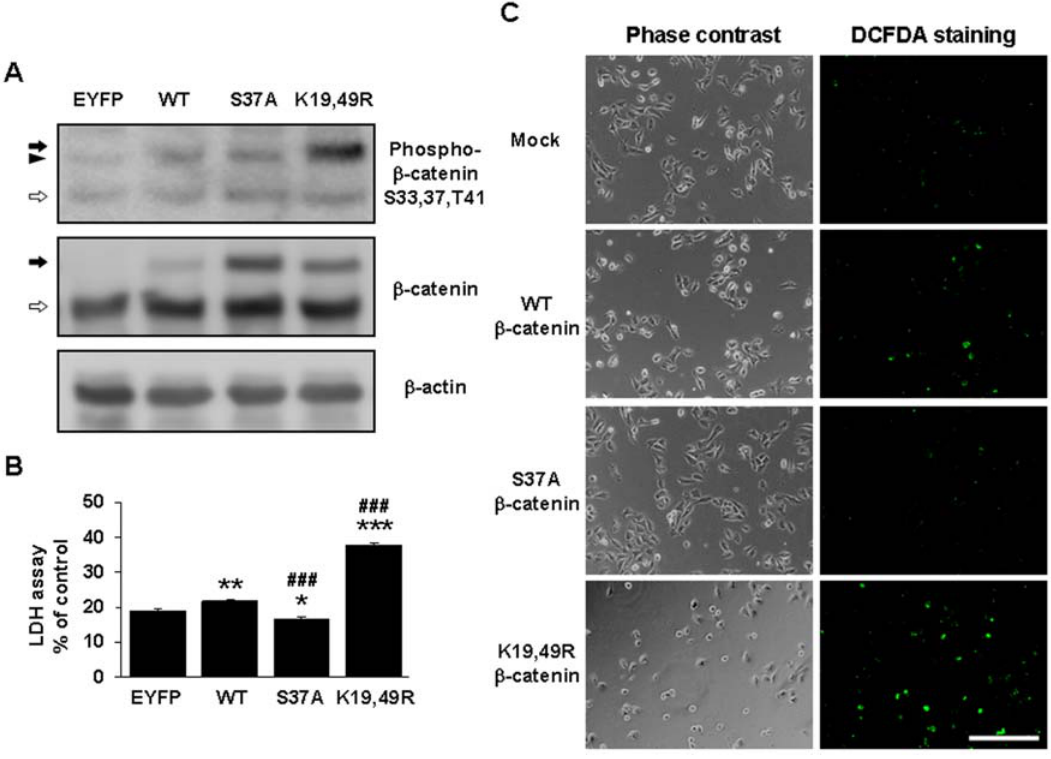
Figure 4. Accumulation of phospho- b -catenin induces cytotoxicity in H4 neuroglioma cells. (A) H4 cells were transiently transfected with EYFP vector, WT, and mutant b -catenin constructs in DMEM for 16 hr. K19/49R b -catenin-transfected cells showed higher immunoreactivity against anti-phospho- b -catenin (S33, 37, T41) without affecting endogenous b -catenin and b -actin levels. Filled and blank arrows indicate exogenous b - catenin-EYFP fusion protein and endogenous b -catenin, respectively. Arrowhead indicates nonspecific bands. (B) LDH release assay showed that K19/ 49R b -catenin induced cytotoxicity in the transfectants. The graph represents (%) of positive control. Data are means 6 SEM values of three independent experiments. * represents significant differences from EYFP vector-transfected H4 cells. *P , 0.05, **P , 0.01, ***P , 0.001. # represents significant differences from WT b -catenin-EYFP-transfected H4 cells. ### P , 0.001. (C) DCFDA staining showing ROS generation of mock and b - catenin-transfected H4 cells. Although fewer cells remained among K19/49R b -catenin tranfectants, the DCFDA signal was much higher than in other transfectants. The white bar represents 200 m m.